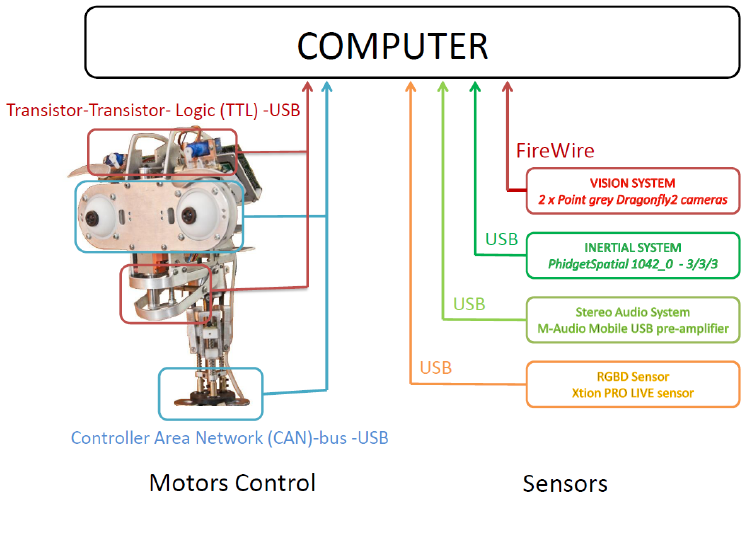
Figure 5. Hardware of the robotic head, Muecas.